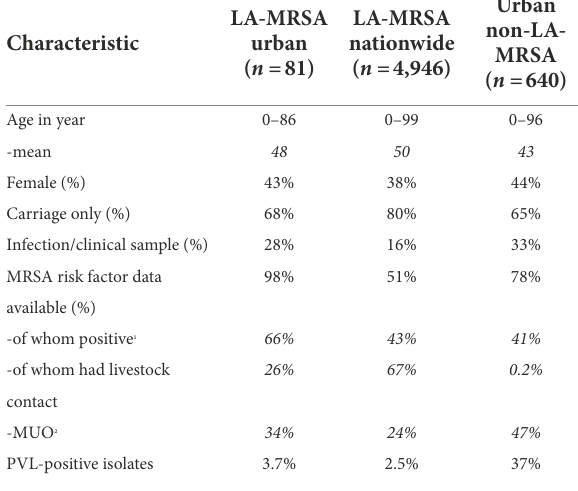
TABLE 1 Baseline characteristics of the study